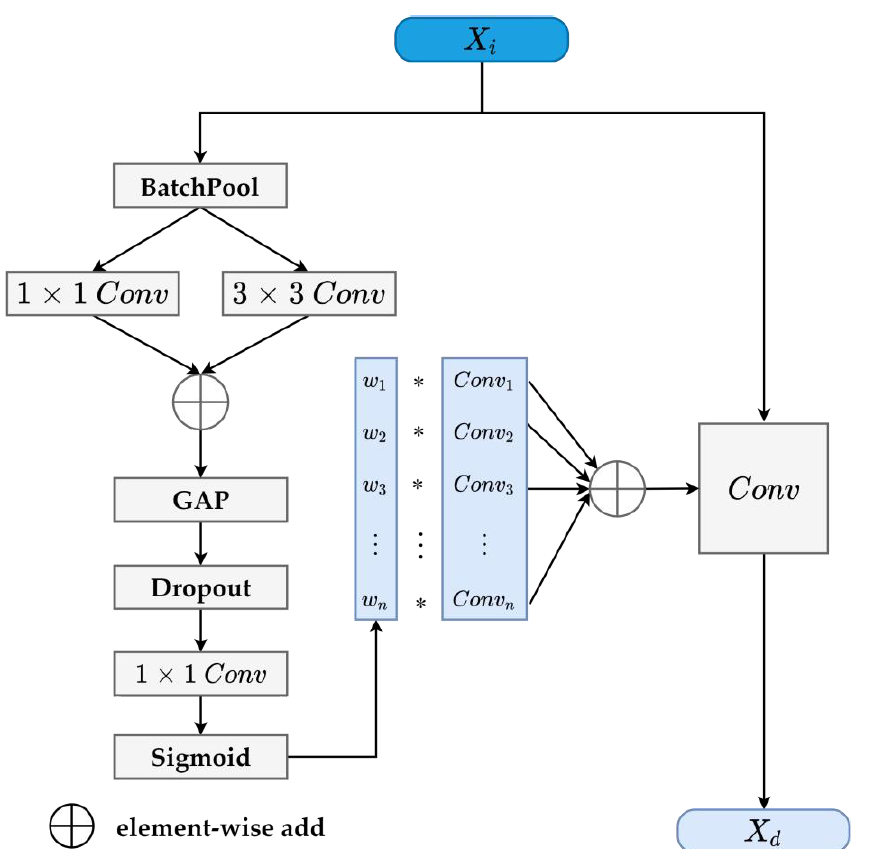
Figure 5. Lightweight dynamic convolution. “ ∗ ” means dot